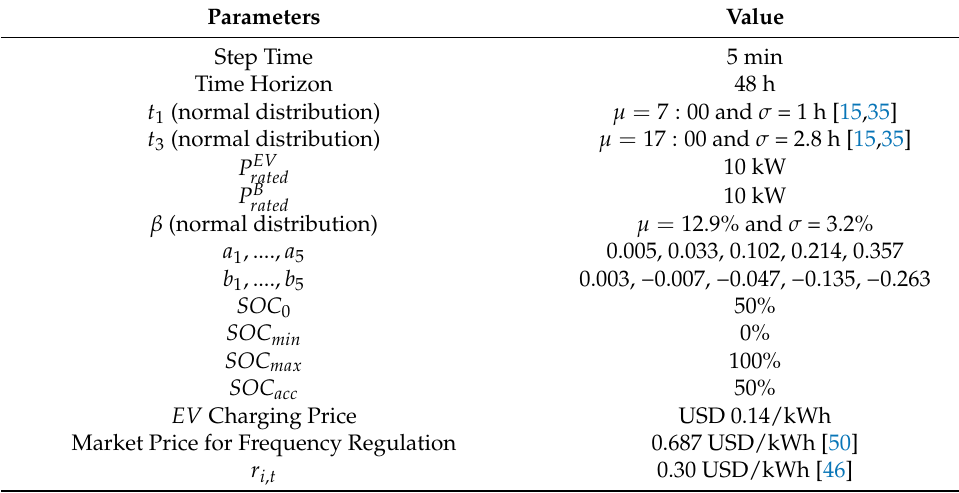
Figure 5. Daily EV energy consumption. Table 1. The main